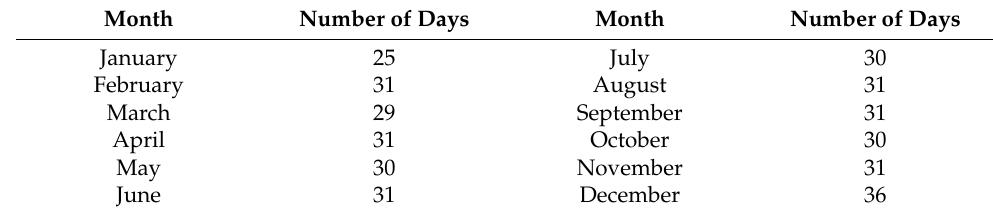
Table 8. Number of days per month in the Asiatic calendar.